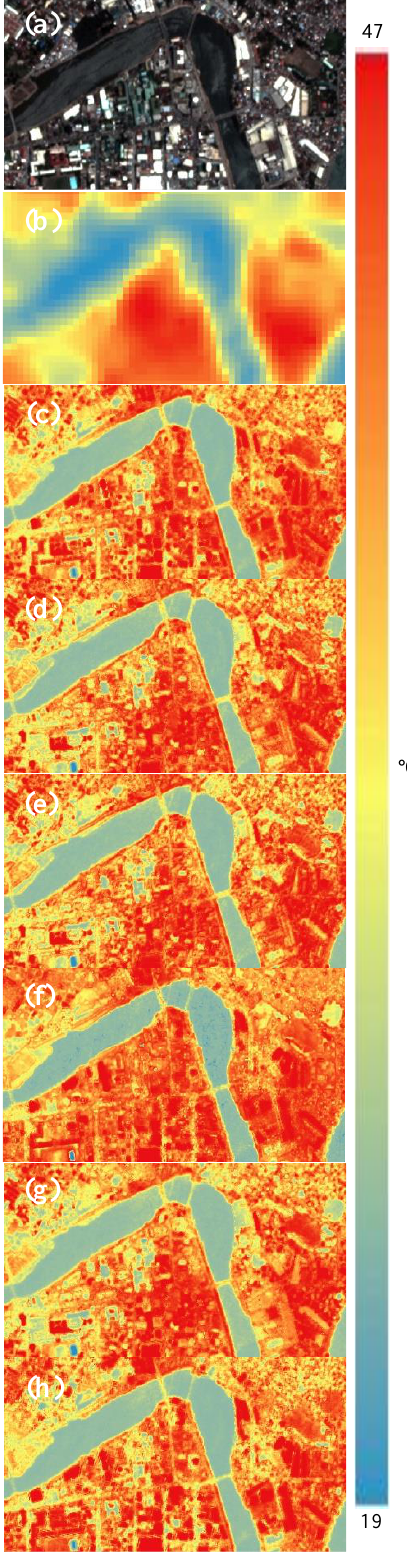
Figure 7. Zoomed-in (a) PlanetScope true color image, (b) Landsat LST, and downscaled LST using (c) EVI/VgNIR- BI/Mean, (d) EVI/VgNIR-BI/Entropy, (e) EVI/VgNIR-BI/ Homogeneity, (f) MSAVI/EVI/Mean, (g) EVI/VgNIR-BI, and (h)